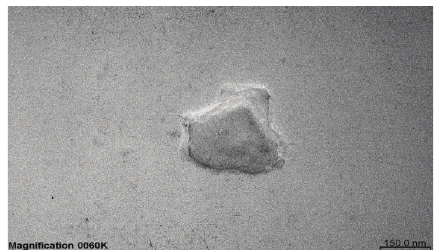
Figure 2: TEM micrograph of a nanosericite particle.